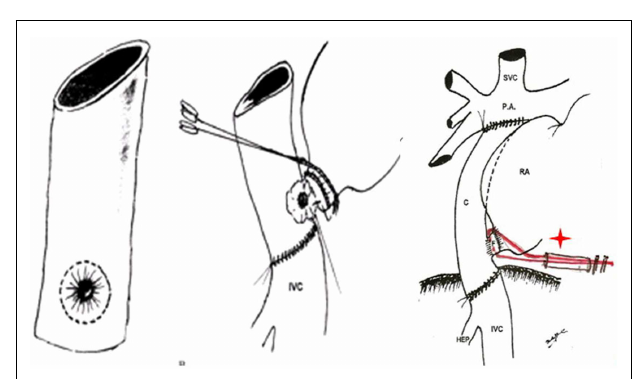
FIGURE 5 | Fenestration with the skirt’s technique with snare* for deferred closing